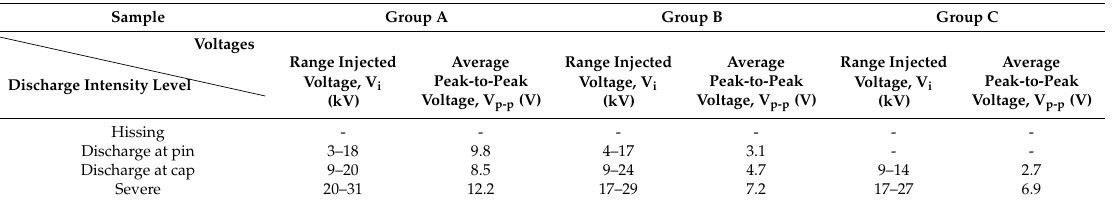
Table 14. Injected voltage and average peak-to-peak voltages of the UV signals for wet insulators conditions with heavy contamination